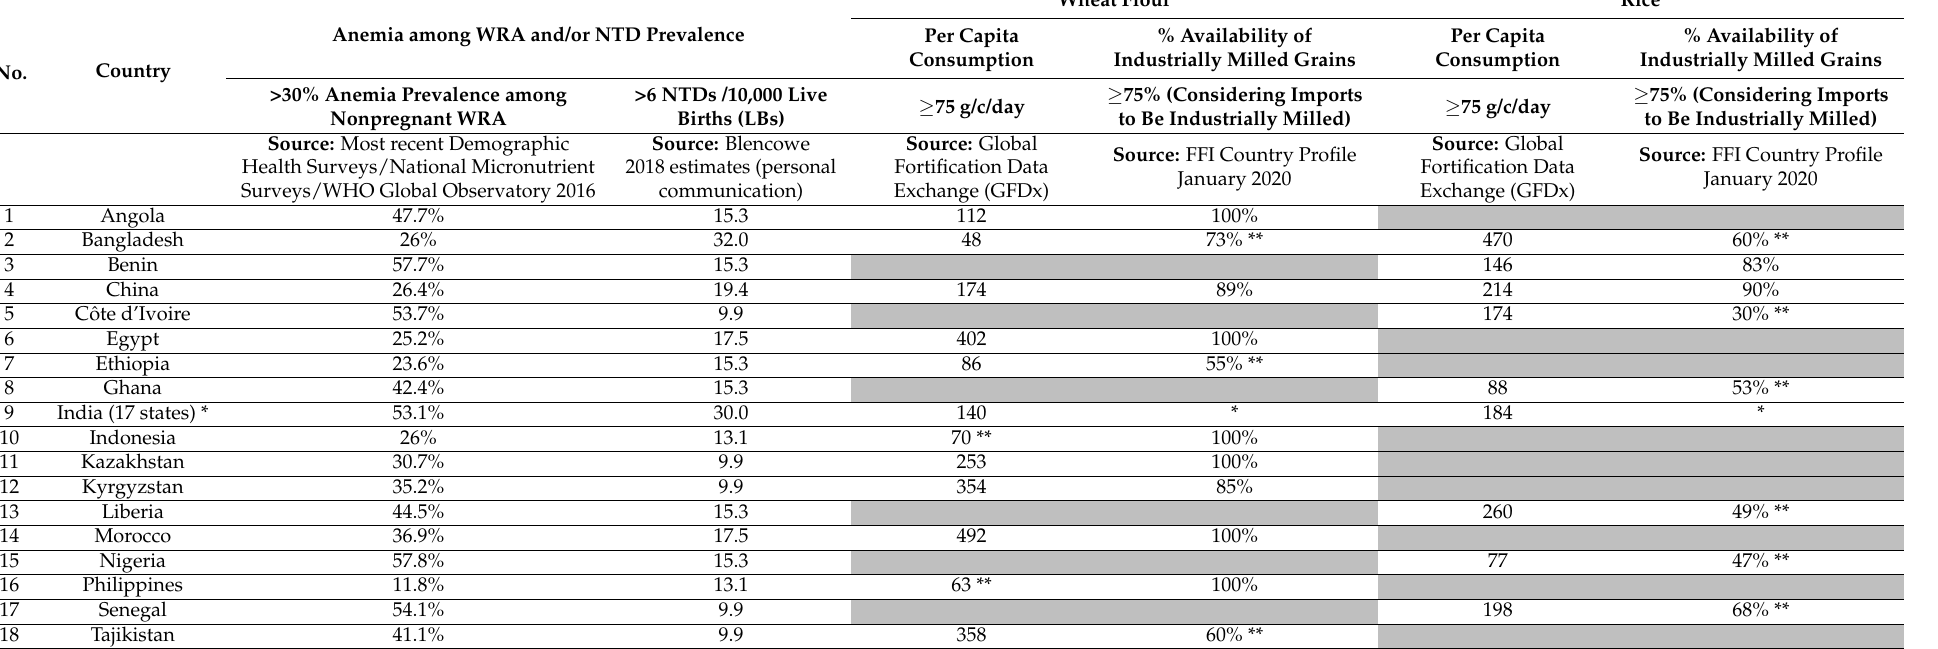
* India was included in consideration of the impact of reaching a large number of people in the eligible 17 Indian states with fortified wheat flour/rice under the country’s largest social protection program, the Public Distribution System, which reaches over 60% of the population. ** Country-specific reasons for selecting countries that did not meet the defined criteria are mentioned in Table 2. FFI: Food Fortification Initiative; GFDx: Global Fortification Data Exchange; LB: live births; NTDs: neural tube defects; No.: number; WHO: World Health Organization; WRA: women of reproductive age. Cells in gray color shade indicate that these countries were not selected for fortification of given food